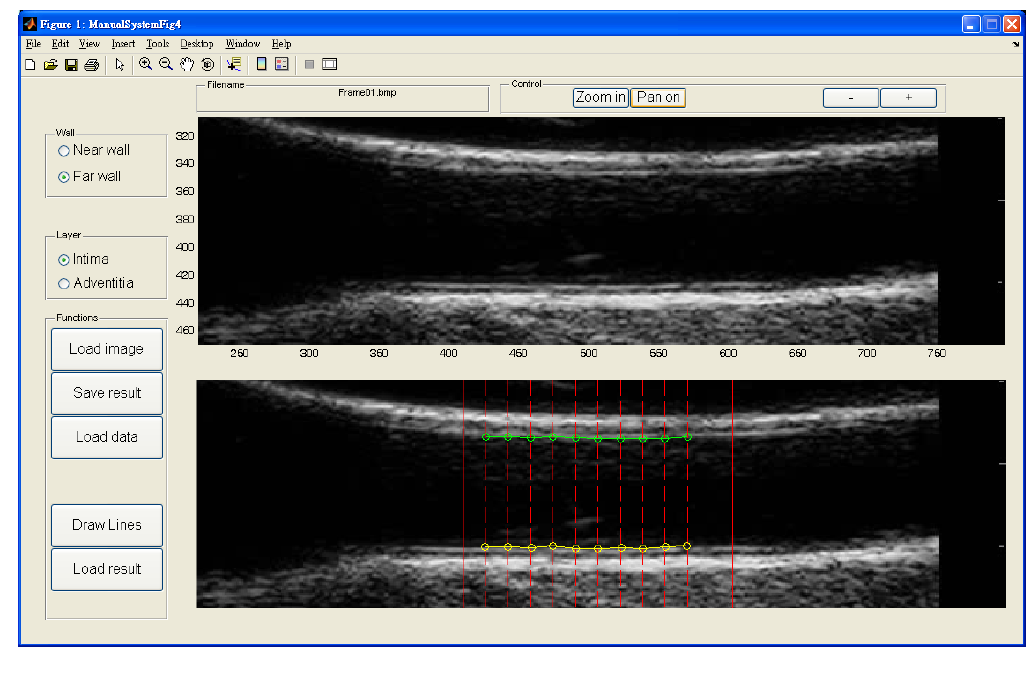
Figure 14. The GUI for manual drawing. The dash lines denote where the expert should give